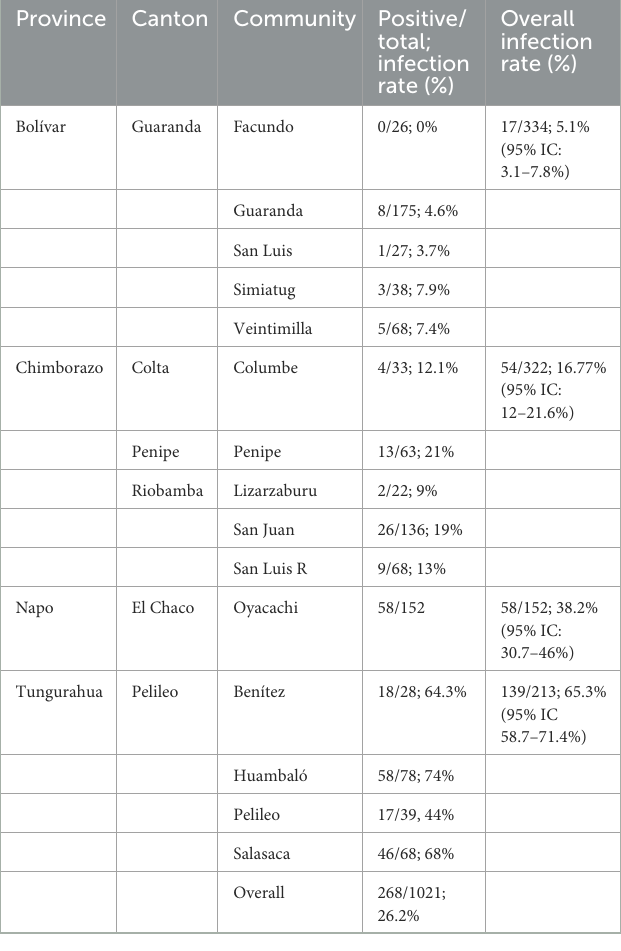
TABLE 2 SARS-CoV-2 infection rates for each province, canton, and community included in this study. Province Canton Community Positive/